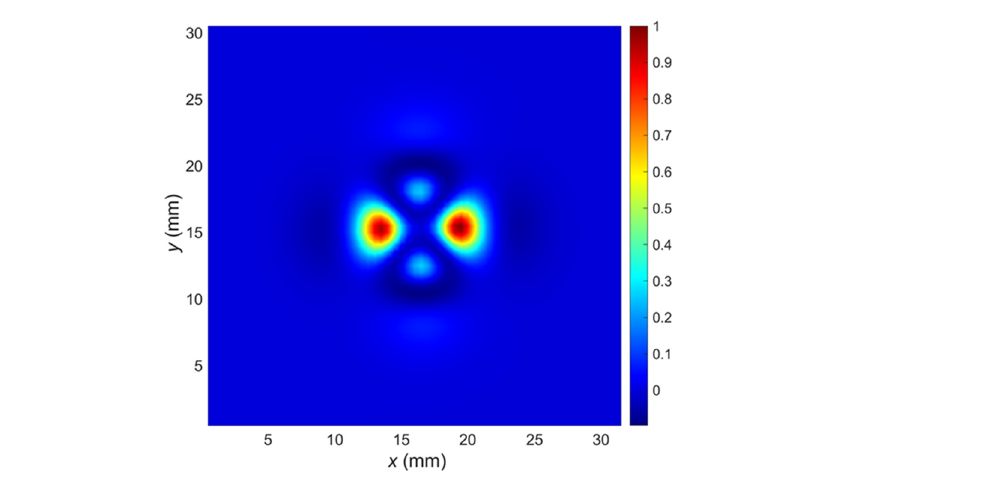
Figure 7. An example of the C-scan (2D plot of the values vs. sensor coordinates, excitation frequency f = 1995 Hz).